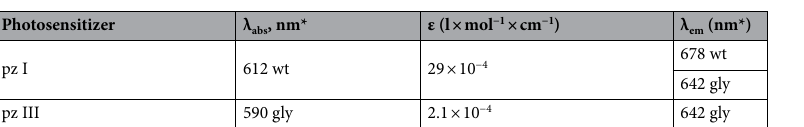
Table 1. Spectral characteristics of the photosensitizers. *As pz I and pz III showed very weak fluorescence in water (wt), their fluorescence was analyzed in an ethanol–glycerol (gly) mixture with a viscosity of about 45 cP.